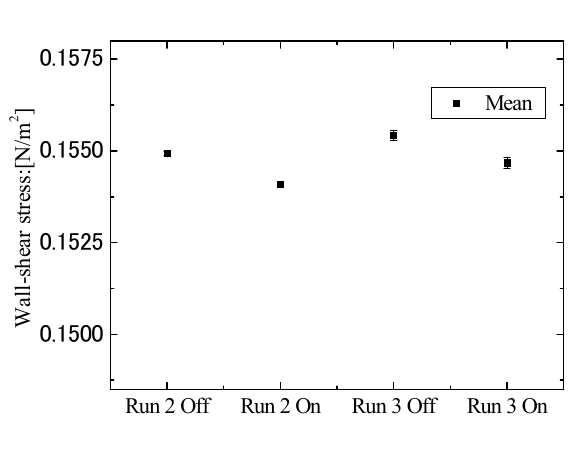
Fig.10 Average stress and errors